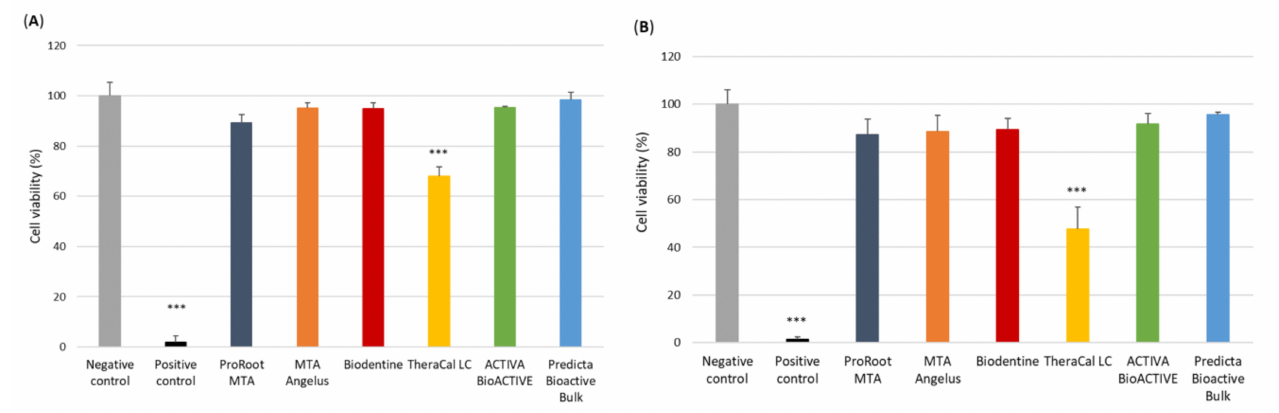
Figure 1. Cytotoxicity of the investigated pulp capping materials. Tests performed using resazurin- based cell viability assay after 24 h ( A ) and 48 h incubation ( B ) of cells with the tested compounds. The positive control was represented by the cells incubated with 100% DMSO, while the negative control cells were cultured in a complete IMDM medium. Statistical significance on the graphs: *** p < 0.001 versus negative control.